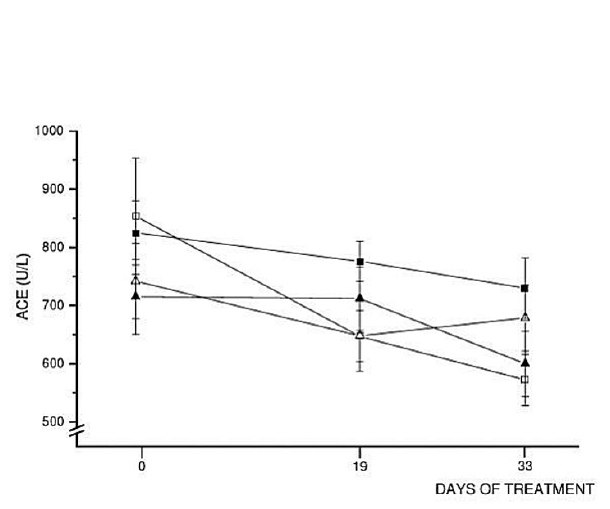
Serum levels of angiotensin-converting enzyme (ACE) activity in normal and streptozotocin-diabetic rats during extended treatment with Bauhinia forfi- cata . (cid:1) normal-control; ■ diabetic-control; (cid:2) normal- treated; ▲ diabetic-treated. All values are means ± standard error (n =